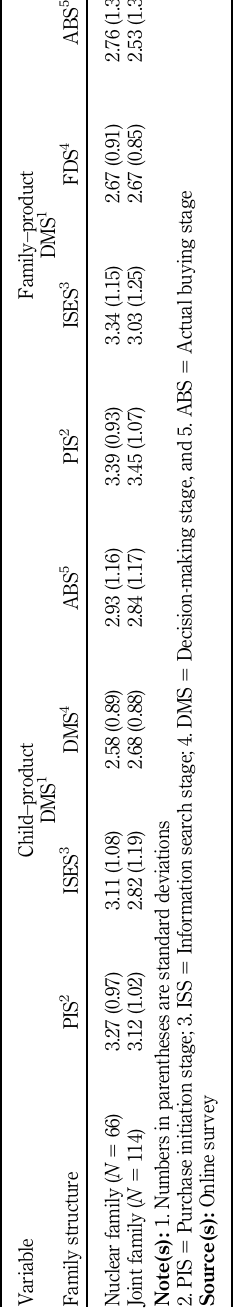
Table 9. Mean scores of children ’ s influence in DMS in Indianfamilies: family